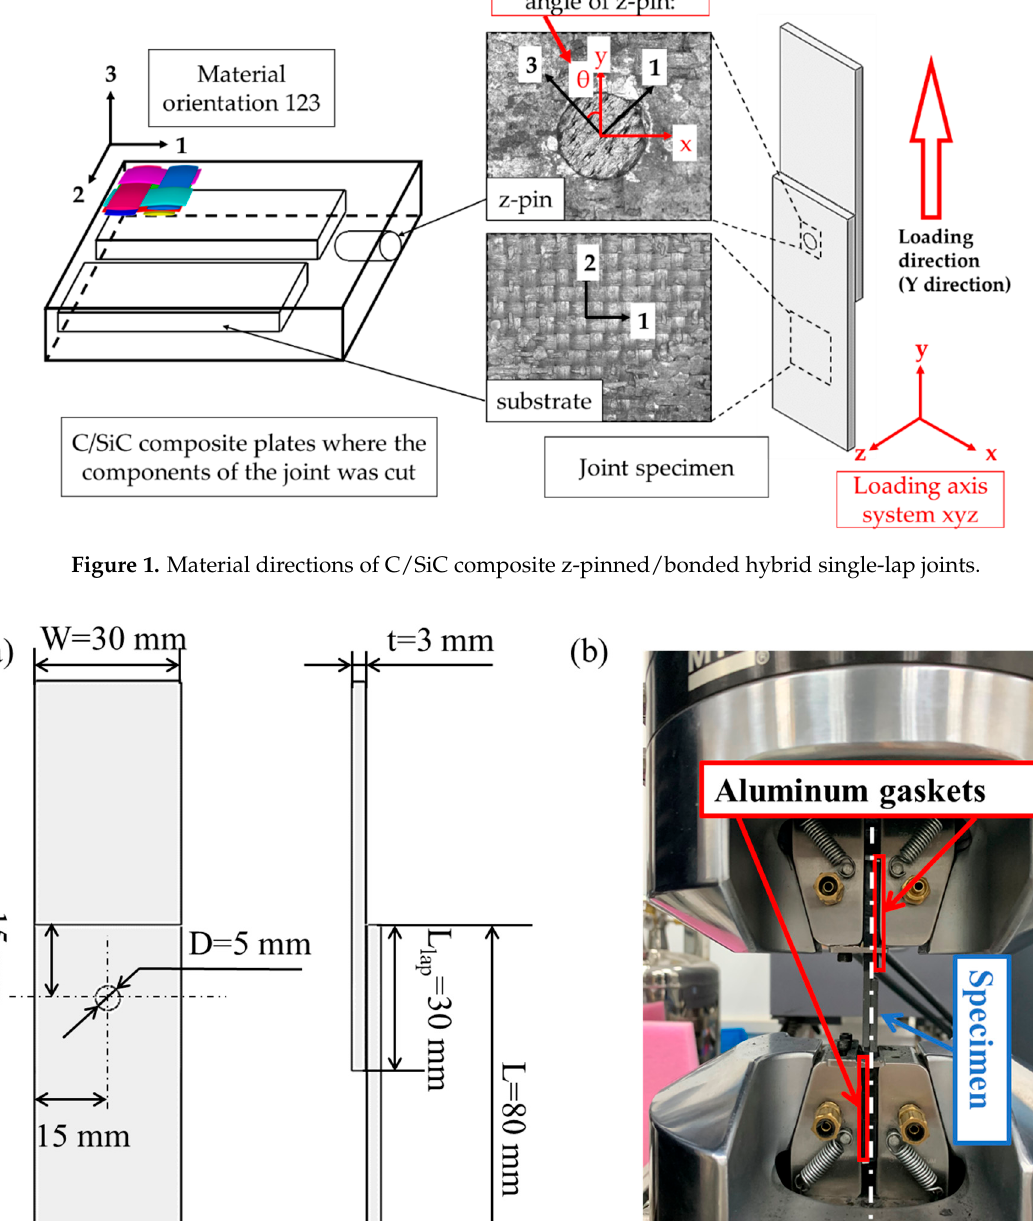
Figure 2. ( a ) Geometric parameters of the tested C/SiC joint; ( b ) Experiment setup.